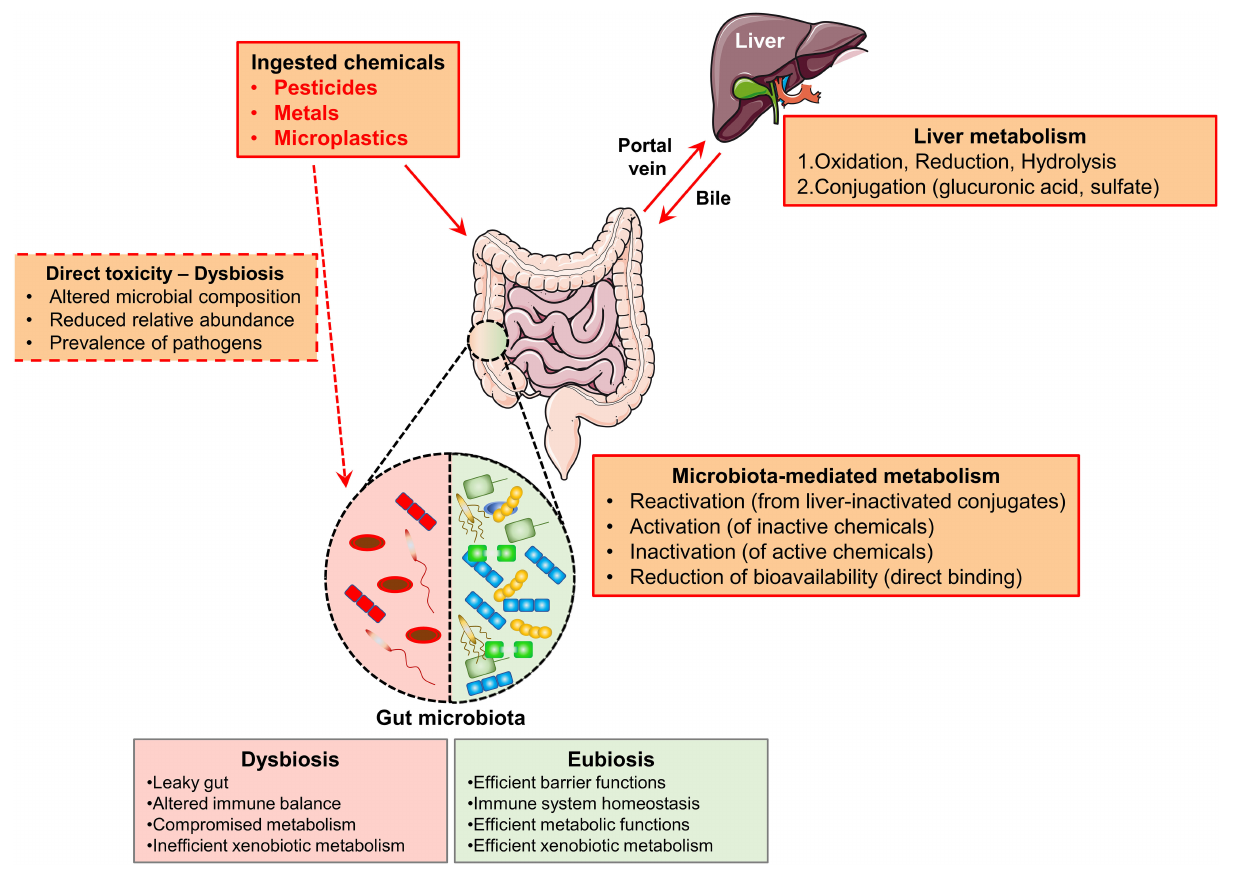
FIGURE 1 | Schematic representation of the biotransformation routes of ingested chemicals. Ingested chemicals (pesticides, metals, microplastics), arrive in the intestine through the oral route. Well-adsorbed compounds are transported to the liver through the portal vein. In the liver, such compounds may be metabolized (through the action of liver enzymes, the compounds are oxidized, reduced, or hydrolysed and finally they are conjugated) and hence released in the intestine within the bile. The gut microbes can: reactivate conjugated chemicals, directly metabolize non-adsorbed chemicals (activation or inactivation), or direct bind such compounds (reducing their bioavailability). Importantly, several chemicals might directly induce microbial dysbiosis (red dotted box). The features of a dysbiotic or eubiotic intestinal microbiota are summarized, respectively, in the red and green boxes.